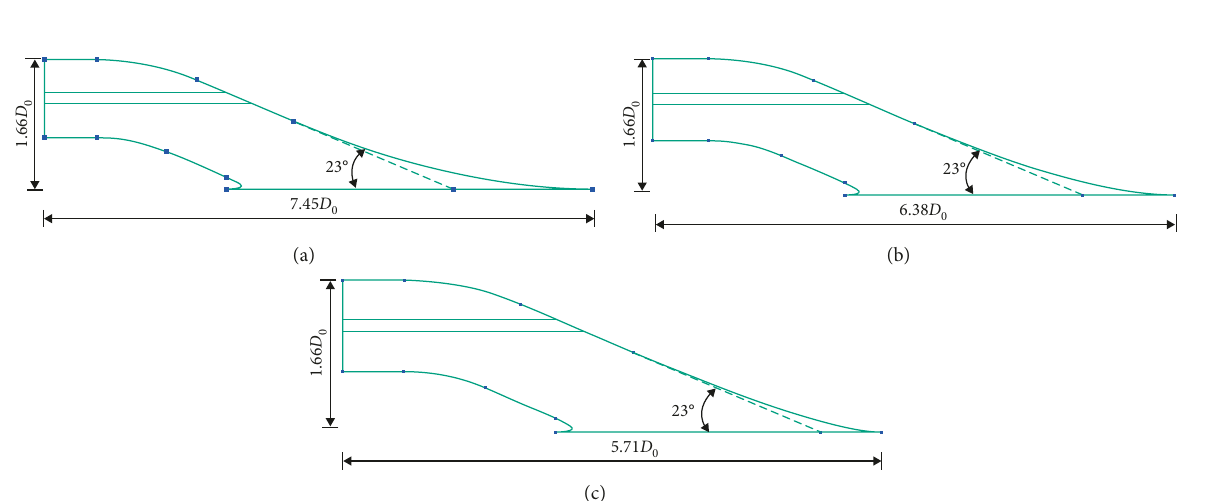
Figure 18: Sketch of the middle section of inlet passages with different lengths. (a) Case 1. (b) Case 2. (c) Case